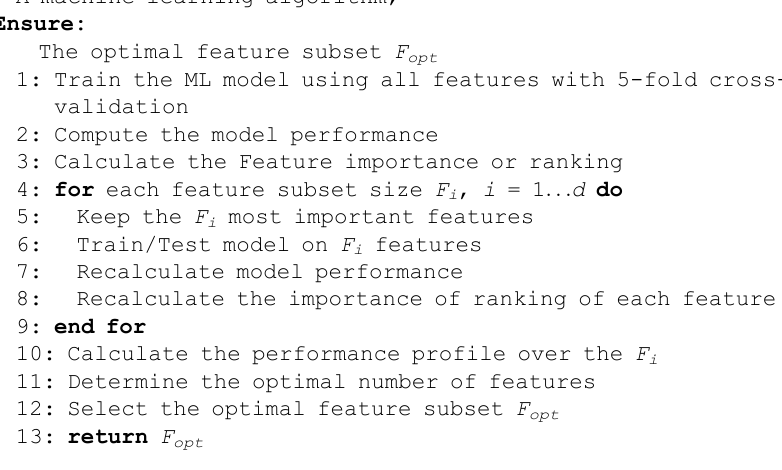
Algorithm 1 Recursive Feature Elimination With